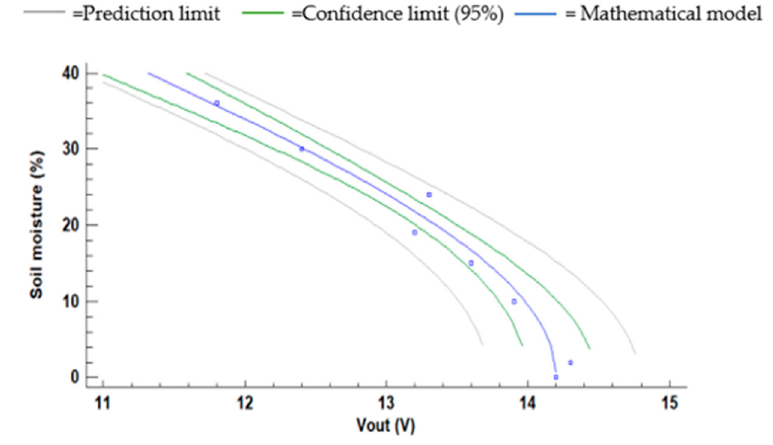
Figure 21. Vout of P8 using S4 and its mathematical model.